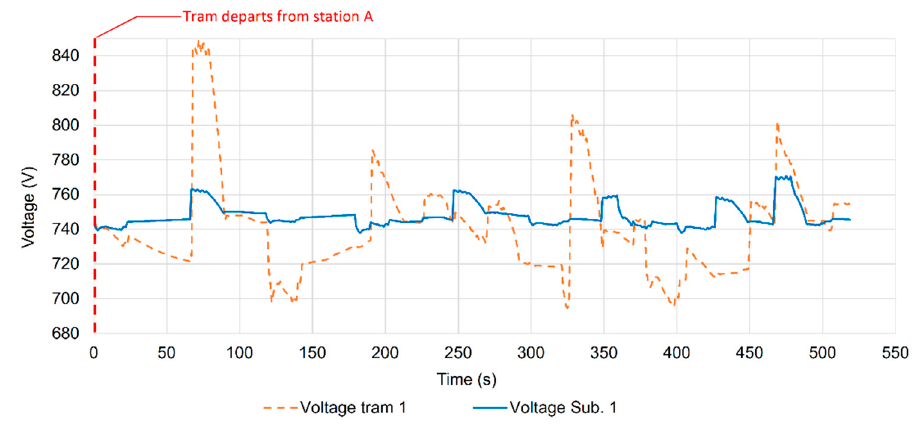
Figure 4. Simulation results (voltage tram 1 and voltage substation 1).